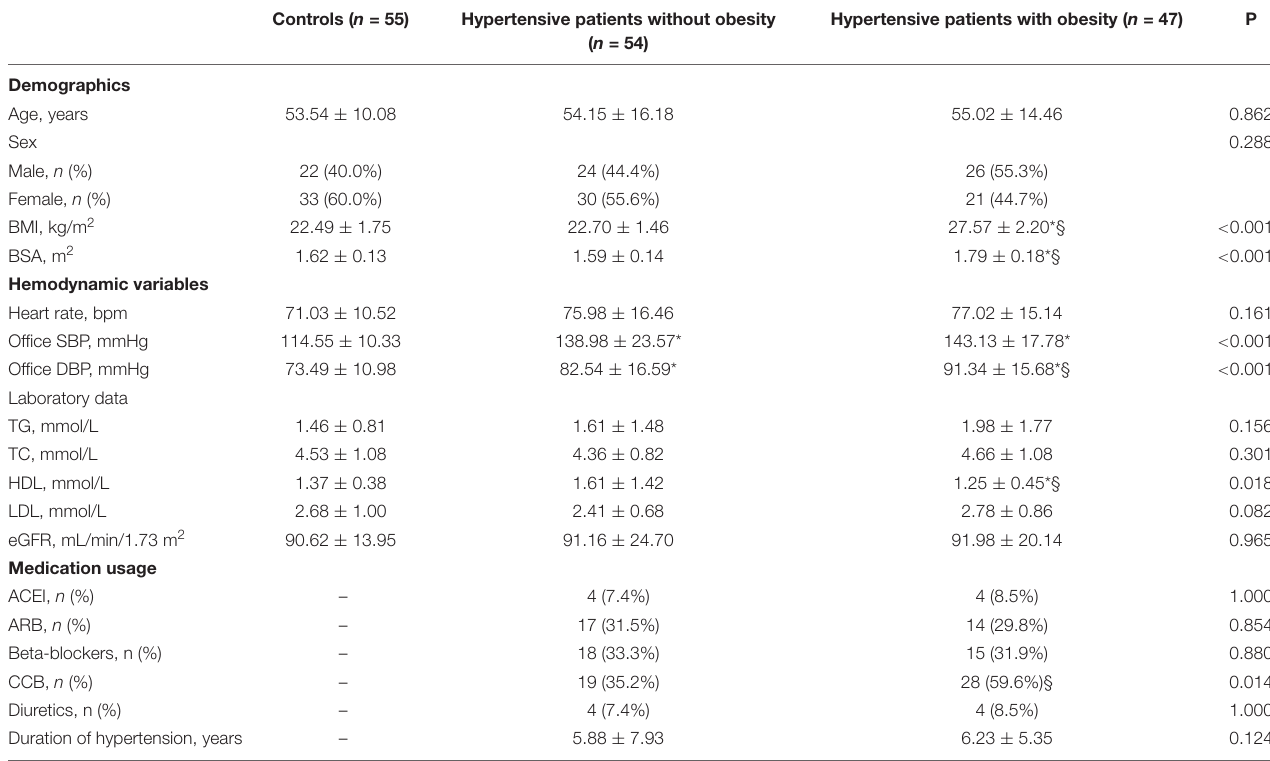
TABLE 1 | Baseline